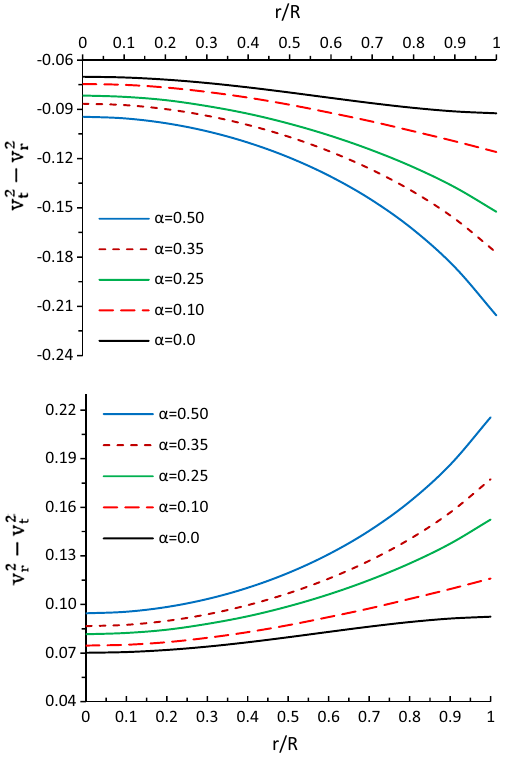
Fig. 5 The variation of radial (v 2 r ) and tangential (v 2 t ) speed of sound verses radial coordinate r / R . For plotting of this figure we have employed same data values as used in Fig. 4